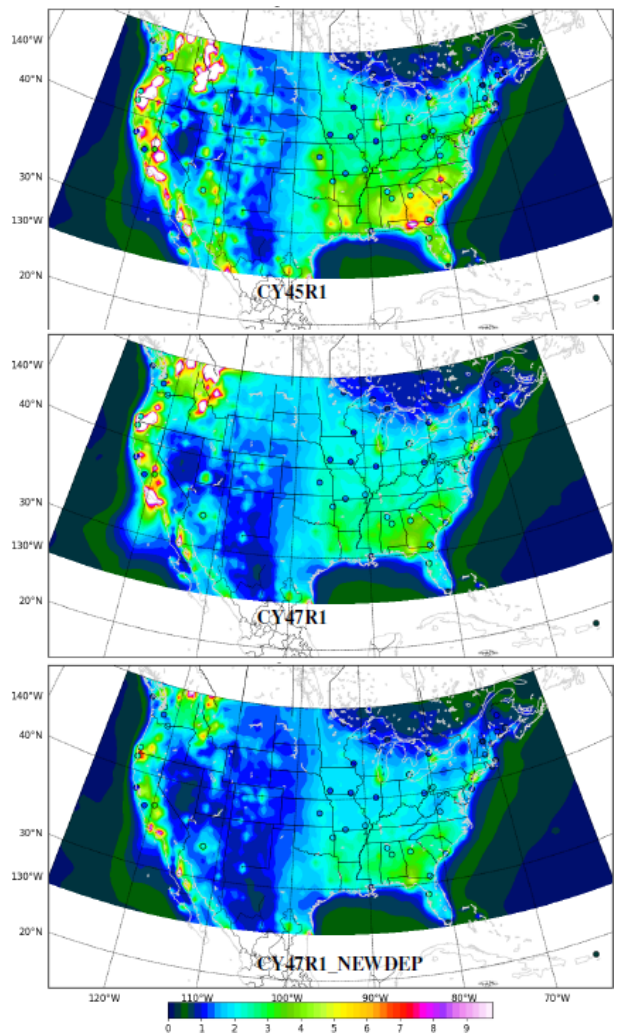
Figure 19. Mean 2017 surface concentration of organic carbon in PM 2 . 5 (in µgm − 3 ) simulated by IFS-AER CY47R1 against the yearly average from the IMPROVE network (shown as black cir- cles).